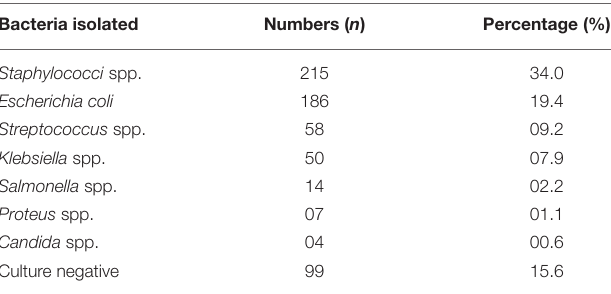
TABLE 5 | The bacteriology of milk ( n = 633) of cattle and buffaloes suffering from mastitis. Bacteria isolated Numbers ( n ) Percentage (%) Staphylococci